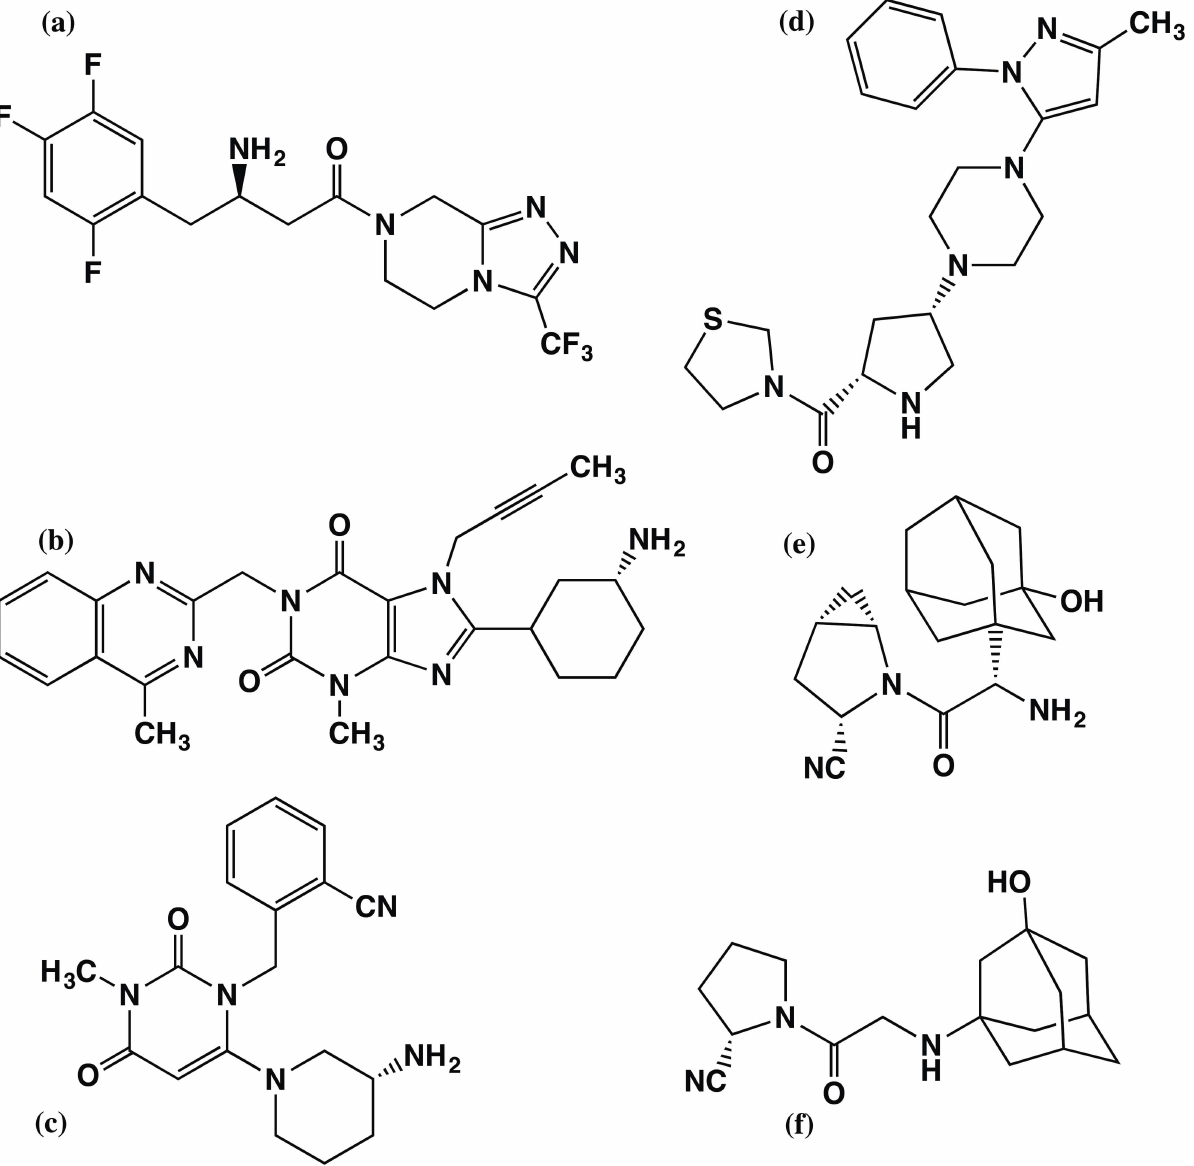
Fig 1. Schematic structure of the DPP-4 inhibitors:(a) sitagliptin, (b) linagliptin,(c) alogliptin,(d) teneligliptin,(e) saxagliptin, and (f) vildagliptin.